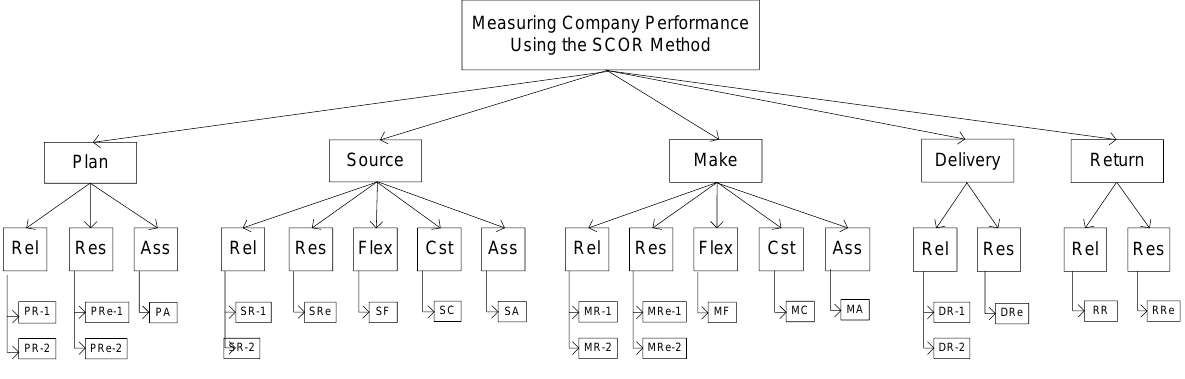
Figure 2. The KPI hierarchy of PT. Multi Anugrah